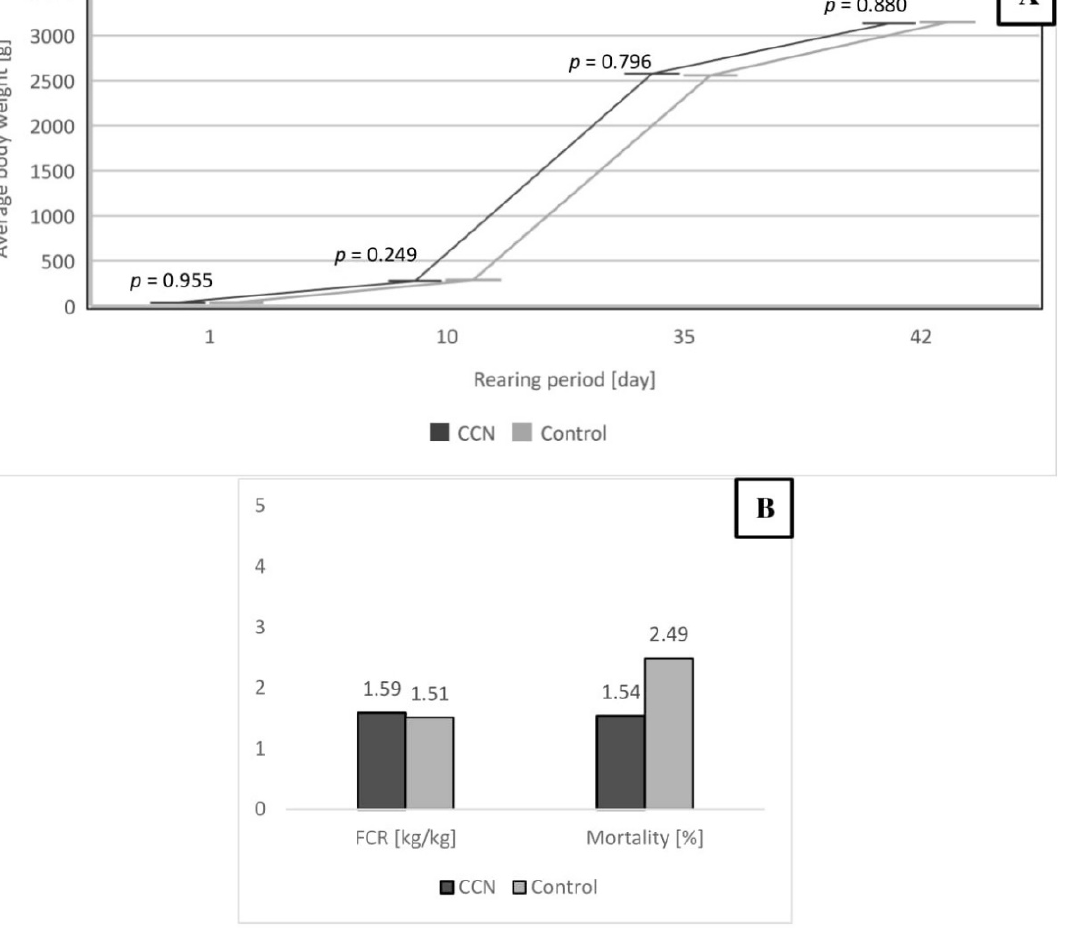
Figure 5. Production results of broiler chickens after 42 d of rearing. Average BW in groups on days 1, 10, 35 and 42. SEM values for average BW on days 1, 10, 35, and 42: 0.239, 3.496, 35.48, and 44.49, respectively ( A ). FCR and mortality of broiler chickens after the rearing period ( B ).